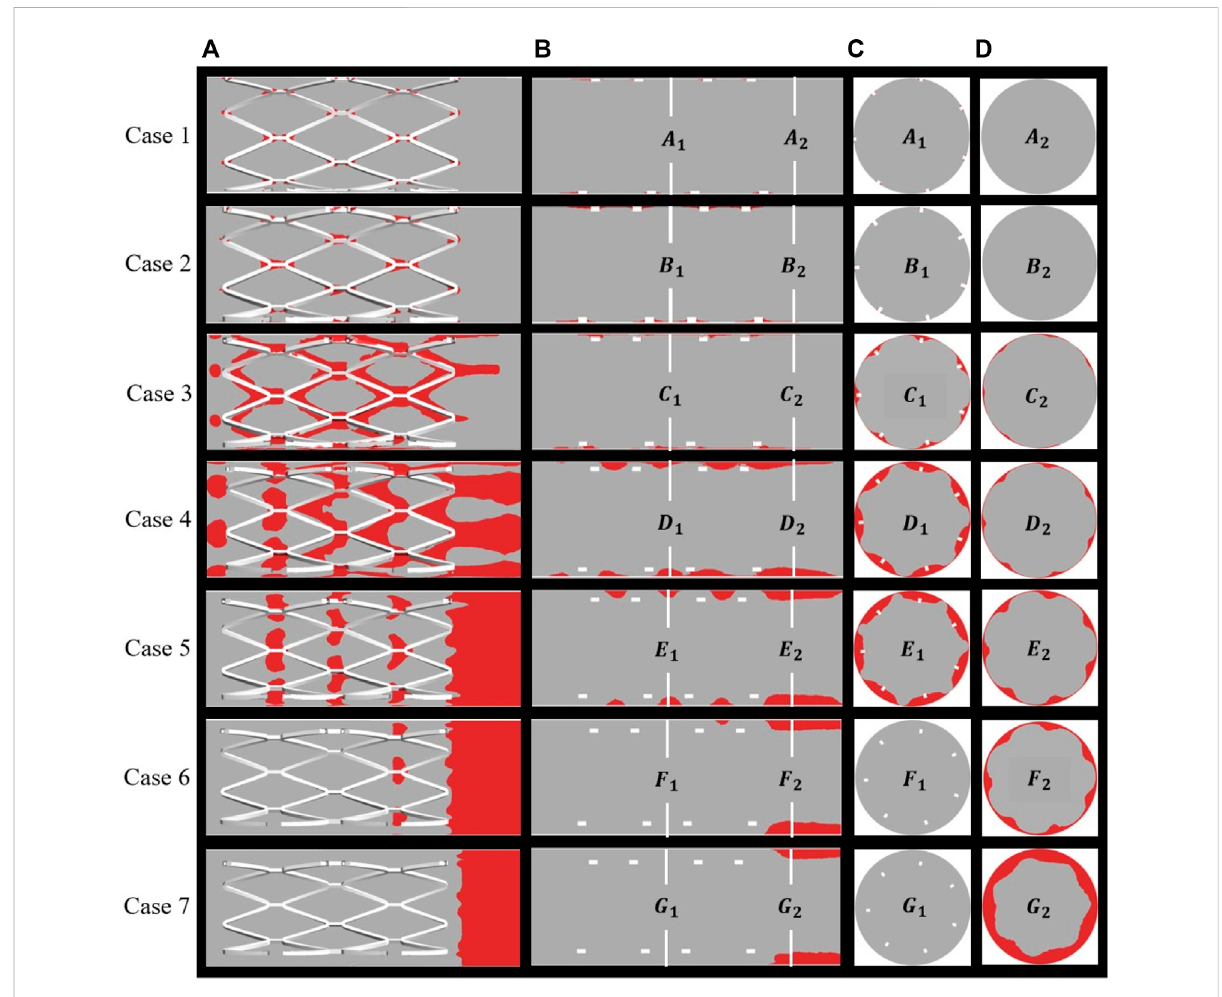
FIGURE 6 Distribution of thrombus at the end of simulation: (A) thrombus on the overall perspective; (B) thrombus on the longitudinal sections and locations of two cross-sections; (C) middle location of the stents; (D) distal end of the